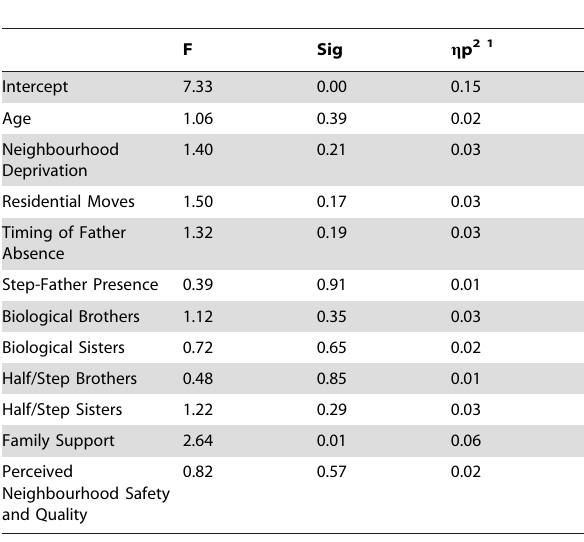
Table 5. Results of a multivariate GLM for the childhood adversity variables plus age on the set of interest in infants